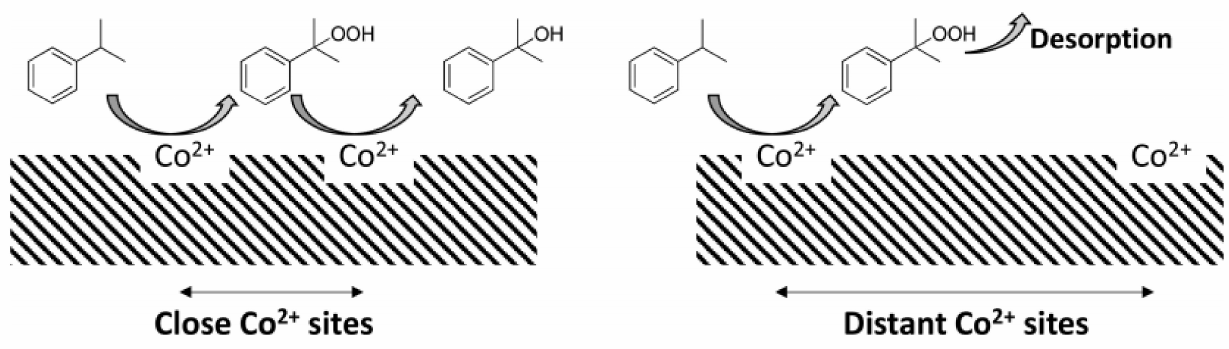
Figure 5. CHP decomposition is a favourable process with close proximity of Co 2+ sites (left part) than with distant isolated Co 2+ sites (right part). Reproduced with permission from